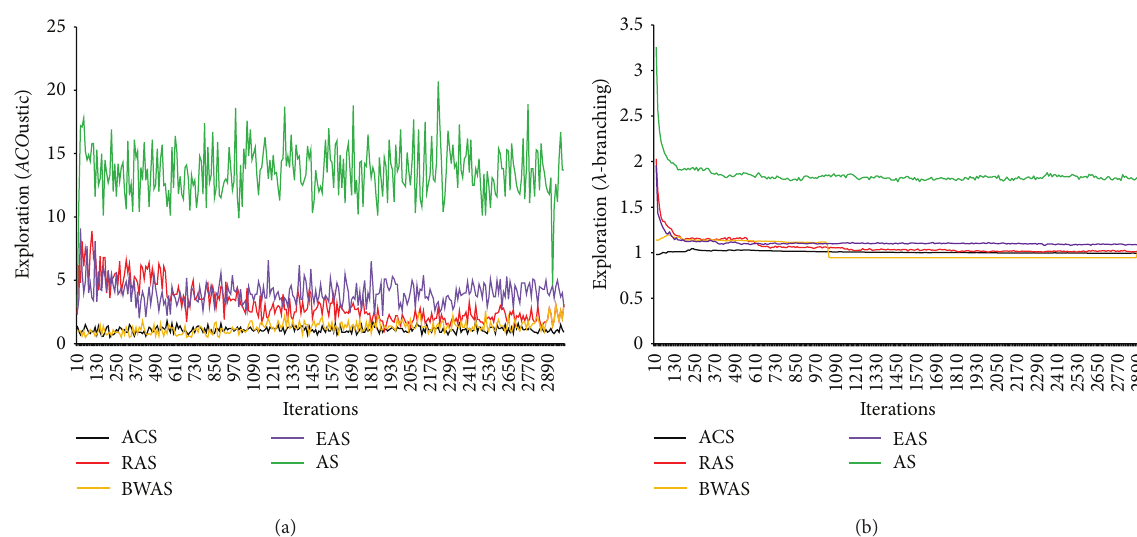
Figure 9: The performance of five ACO algorithms using the ACO ustic (a) and branching factor indicator (b) for a DIMACS instance size = 2000 and seed = 39200 generated using portgen.